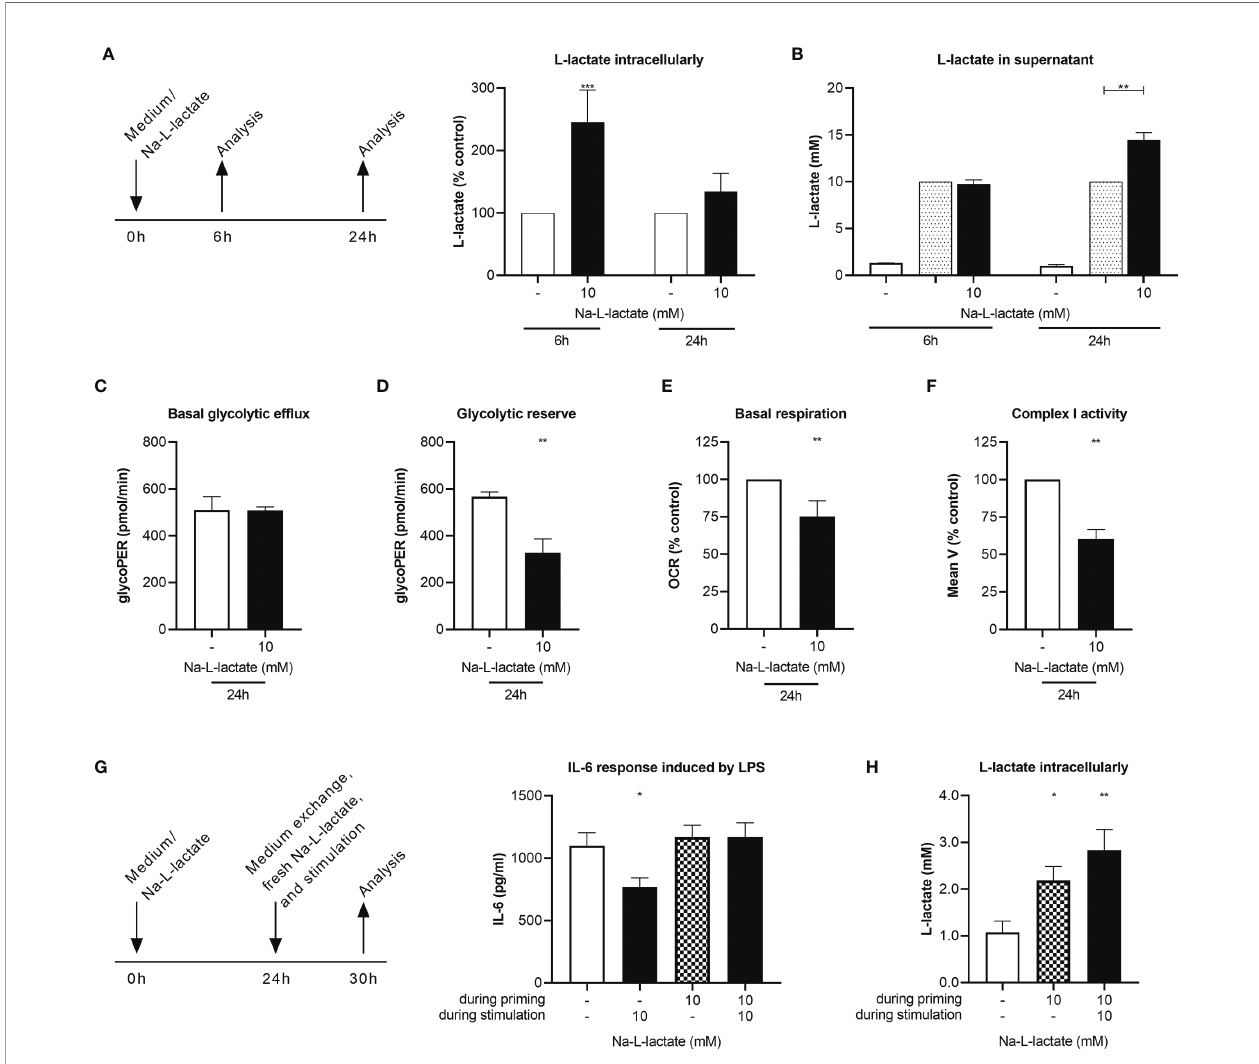
FIGURE 4 | Long-term priming induces lactate resistance. (A) Intracellular and (B) supernatant L-lactate concentration after a six- or 24-hour priming with 10mM Na-L-lactate. (C) Basal glycolytic ef fl ux, (D) glycolytic reserve, (E) basal respiration, and (F) activity of complex I of the respiratory chain after a 24-hour priming with 10mM Na-L-lactate. (G) IL-6 secretion and (H) intracellular L-lactate concentration after 24 hours priming with Na-L-lactate as indicated and subsequently stimulation for six hours with LPS in the presence of fresh 10mM Na-L-lactate as indicated. Data are shown as (A, E, F) mean + SD or (B, D, G, I) mean + SEM (n=5; except for (B) n=4 and (F) n=3). Group comparisons were performed by (C, D) unpaired t test or (G, H) one-way ANOVA followed by Fisher ’ s LSD test. (A, B, E, F) One sample t tests were performed against the theoretical values 100 or 10 respectively (*** P ≤ 0.001, ** P ≤ 0.01, * P ≤